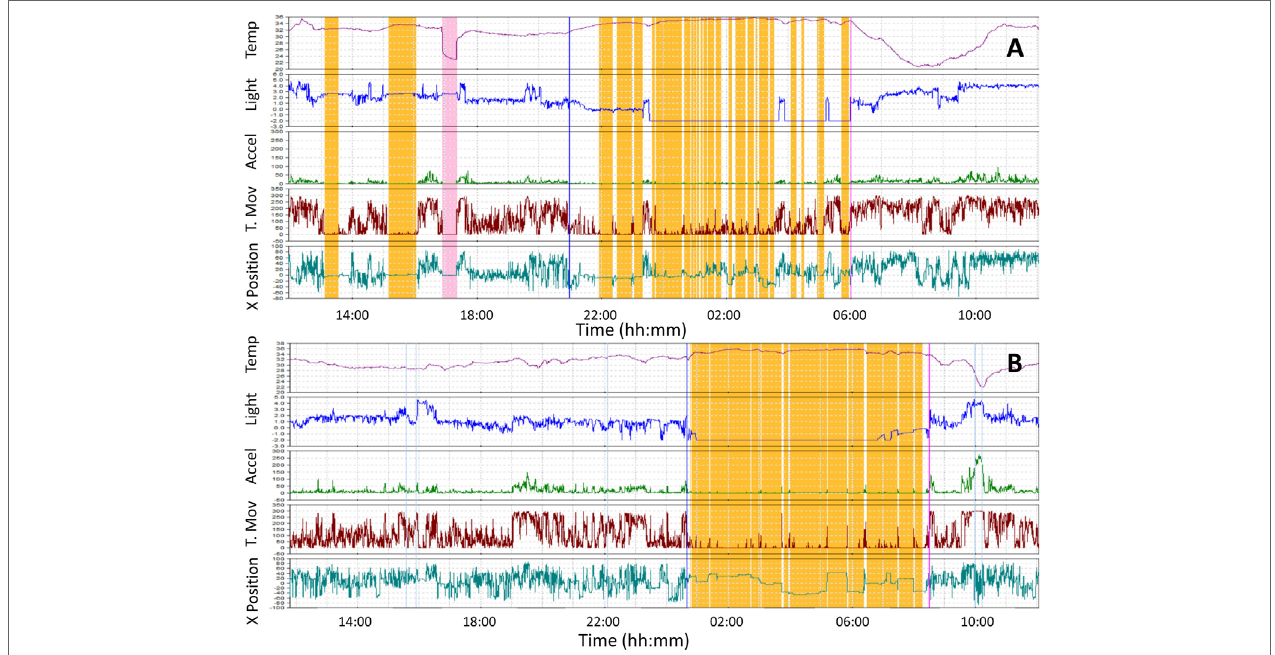
FigUre 2 | Wrist temperature, light exposure, motor acceleration, time in movement, and 24 h sleep recordings representative for two subjects monitored in our study, one with Parkinson’s disease (PD) (a) and a healthy control (B) . Note the high nocturnal sleep fragmentation, diurnal sleep, and low motor acceleration of PD. Skin temperature is shown as a red line, visible light in blue, acceleration in green, time in movement in dark red and wrist position (X tilt) in bluish green. Sleep is shown in orange bars. Sensor retrival is indicated by a pink